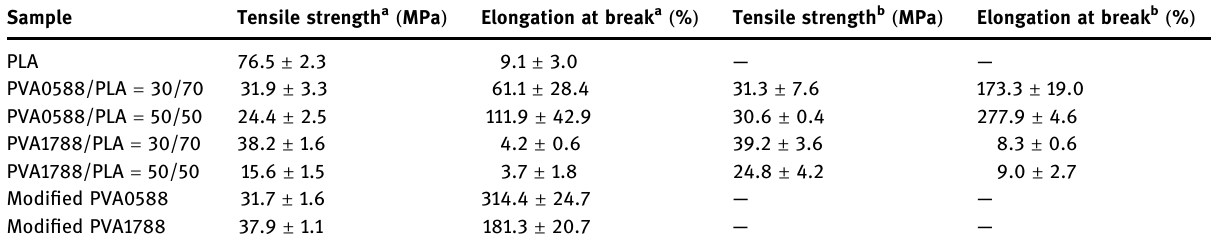
Table 3: Mechanical properties of PLA and PVA/PLA blends before degradation Sample